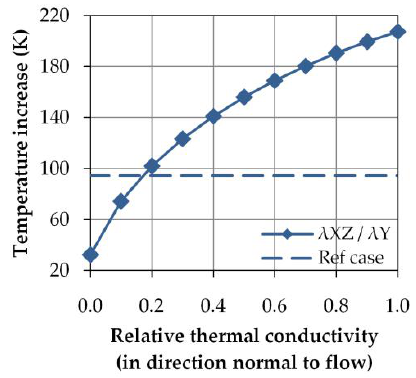
Figure 12. Example of a comparison of MWA temperature increase within the full model (nine layers of 3-mm spheres) with temperature increase within porous medium as a function of relative thermal conductivity (fluid flow direction parallel to Y axis).